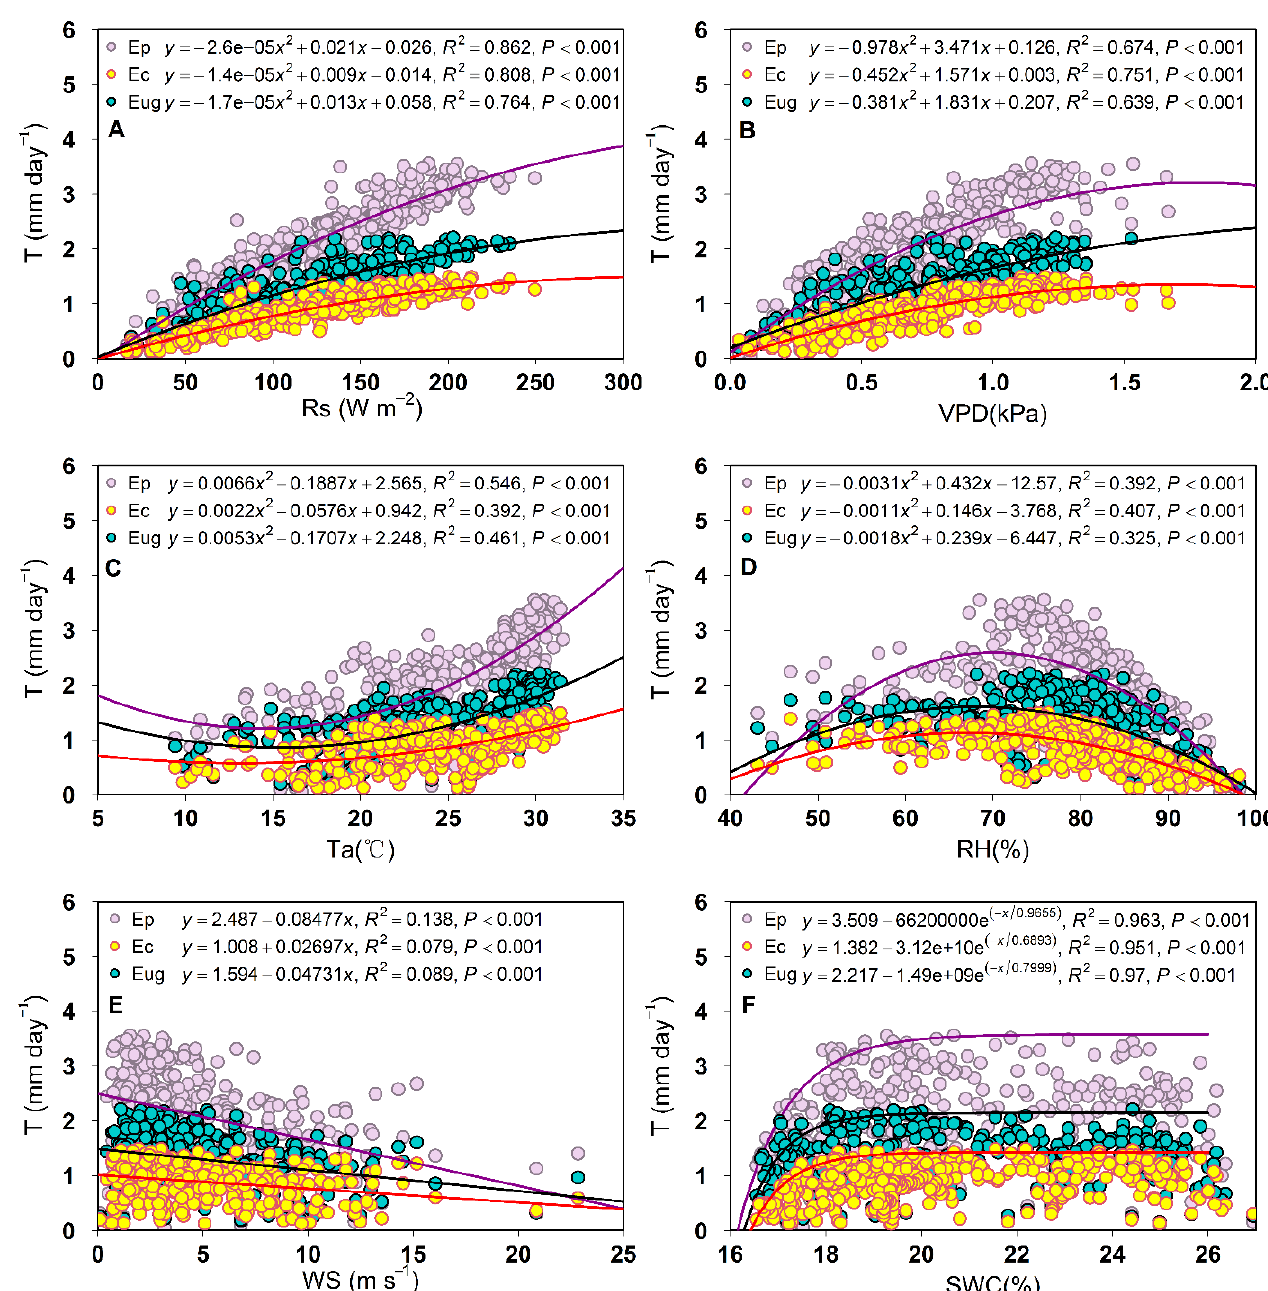
Figure 5. The relationships between the daily stand transpiration (T, mm day − 1 ) and six environmental factors: ( A ) solar radiation (Rs, W m − 2 ), ( B ) vapor pressure deficit (VPD, kPa), ( C ) air temperature (Ta, °C), ( D ) air relative humidity (RH, %), ( E ) wind speed (WS, m s − 1 ), and ( F ) soil moisture content (SWC, %) during the experimental periods. Ep, Ec, and Eug represent the eucalyptus species of E. pellita, E. camaldulensis, and E. urophylla × E. grandis , respectively.